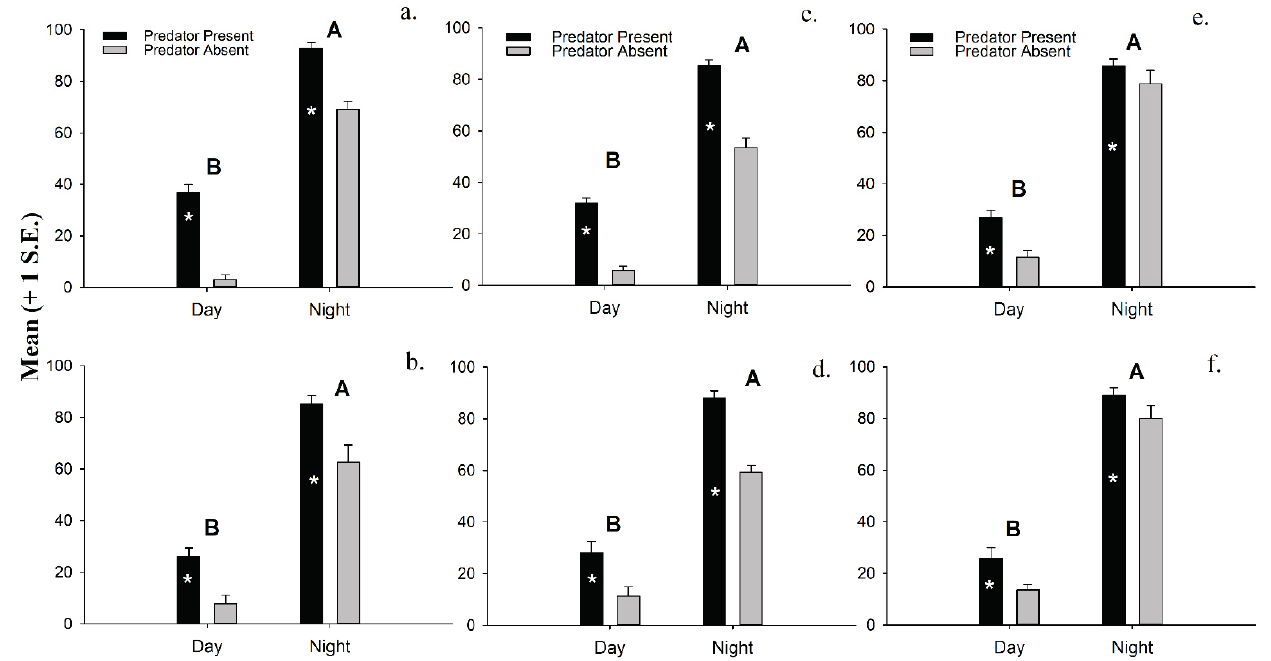
Figure 3. ( a ). Macroinvertebrate emergence density (mean + 1 S.E.) of ( a ). ostracods, ( b ). polychaetes, ( c ). amphipods, ( d ). isopods, ( e ). mysids, and ( f ). tanaids in the laboratory experiments. * Indicates significant differences between treatments ( p < 0.05). Table 1. Results of the analyses of variance conducted on the proportion of benthic invertebrates emerging from sediments in the presence/absence of a predator and time of day in the microcosm experiments. Results are considered significant when p < 0.05.